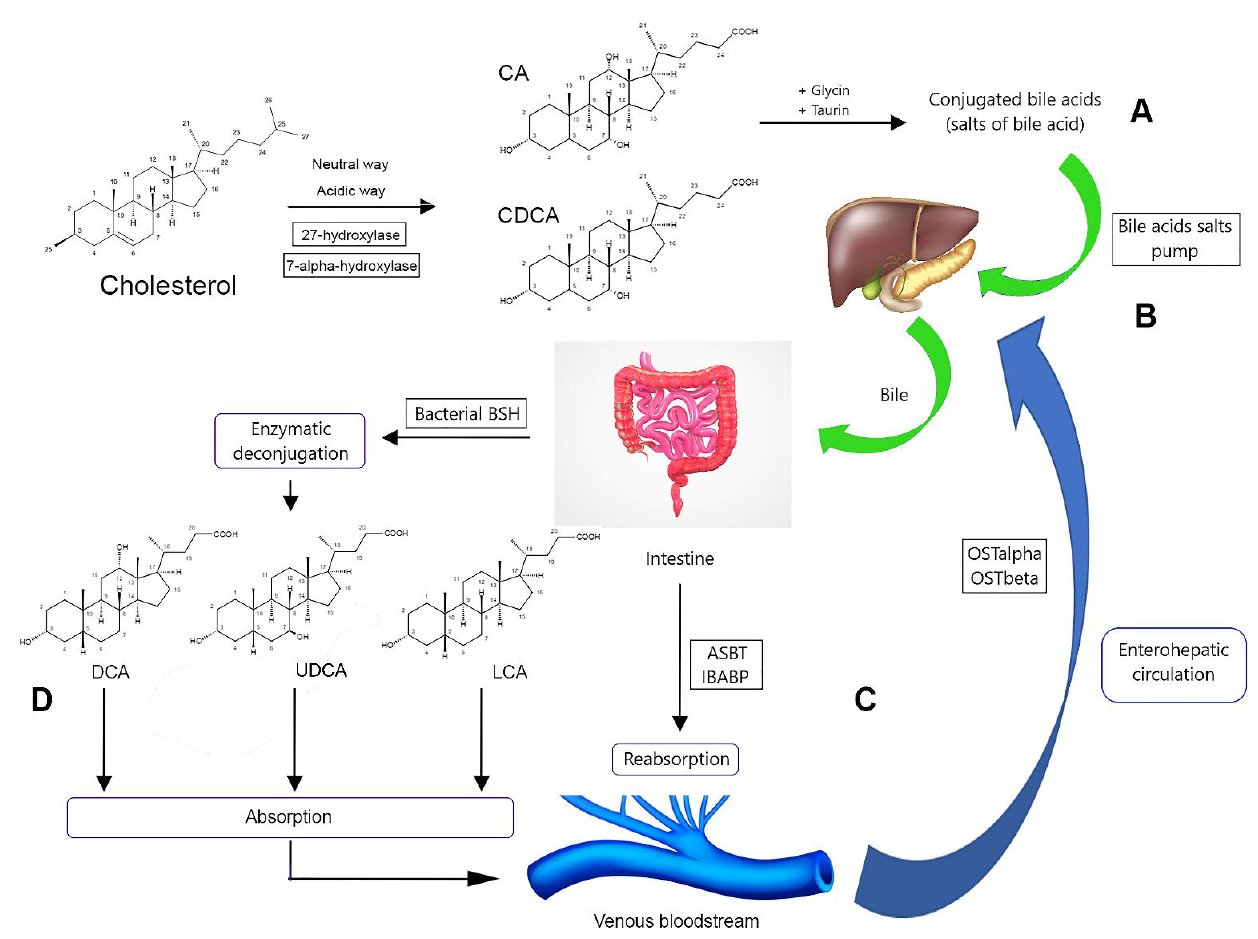
Figure 2. The circulation of bile acids in the human organism. ( A ) Primary bile acids are produced via cholesterol hydroxylation and then conjugated with glycine and taurine, forming salts. ( B ) The bile acids salts pump transfers them into the liver where the salts are transported in bile. ( C ) In the intestine, conjugated bile acids are reabsorbed in the blood and transported into the liver again (enterohepatic circulation). ( D ) Some bile acids undergo enzymatic deconjugation and are also transported into the liver. ASBT, Apical Sodium-Dependent Bile Acid Transporter; IBABP, Ileal Bile Acid-binding Protein; BSH, Bile Salt Hydrolase; OST, Organic Solute Transporters; LCA, lithocholic acid; UDCA, ursodeoxycholic acid; DCA, deoxycholic acid.